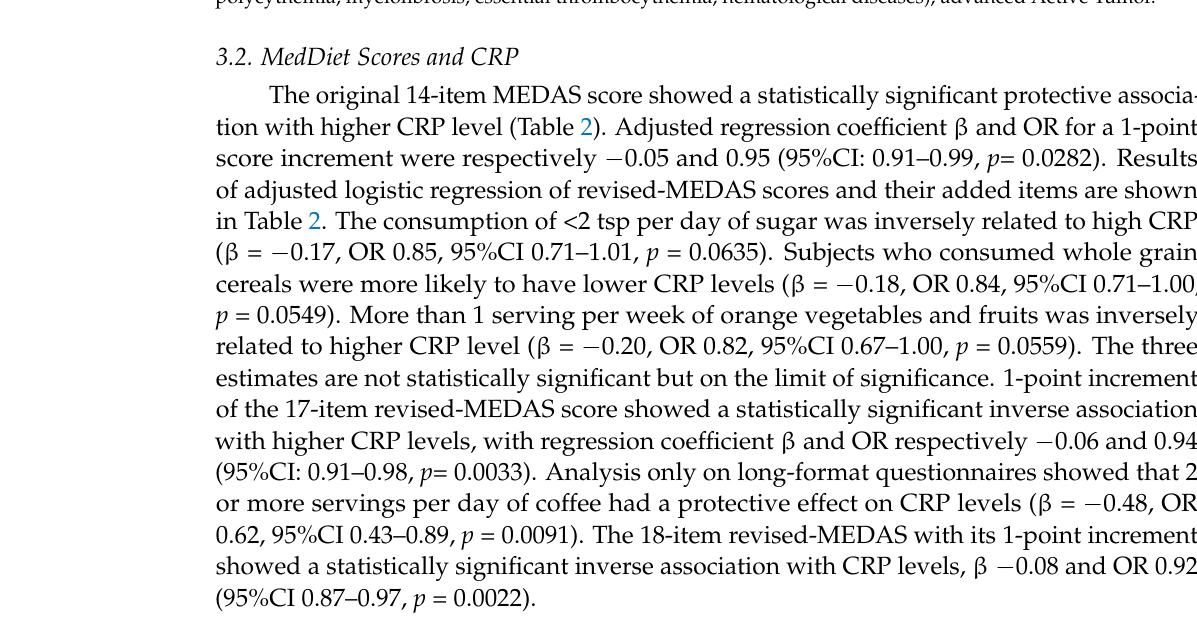
Table 2. Multivariable logistic regression model of C -Reactive Protein (CRP) ≥ 2 mg/L versus CRP < 2 mg/L according to: (a) the original 14-item MEDAS score, (b) 17-item revised-MEDAS score and its single added food items, and (c) 18-item revised-MEDAS and the added food item. N.